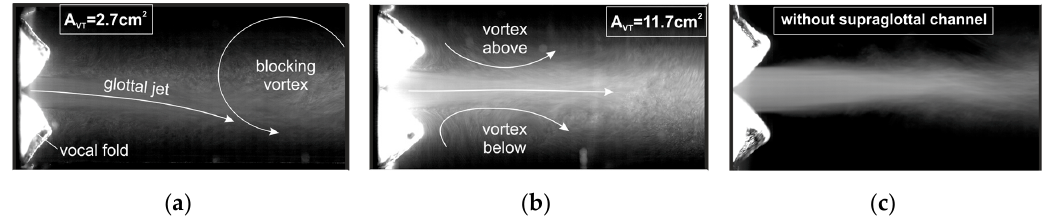
Figure 9. Flow structures in the supraglottal channel for vocal tract areas ( a ) 2.7 cm 2 , ( b ) 11.7 cm 2 , and for ( c ) no vocal tract. Additional information about the flow structures can be found in [40].